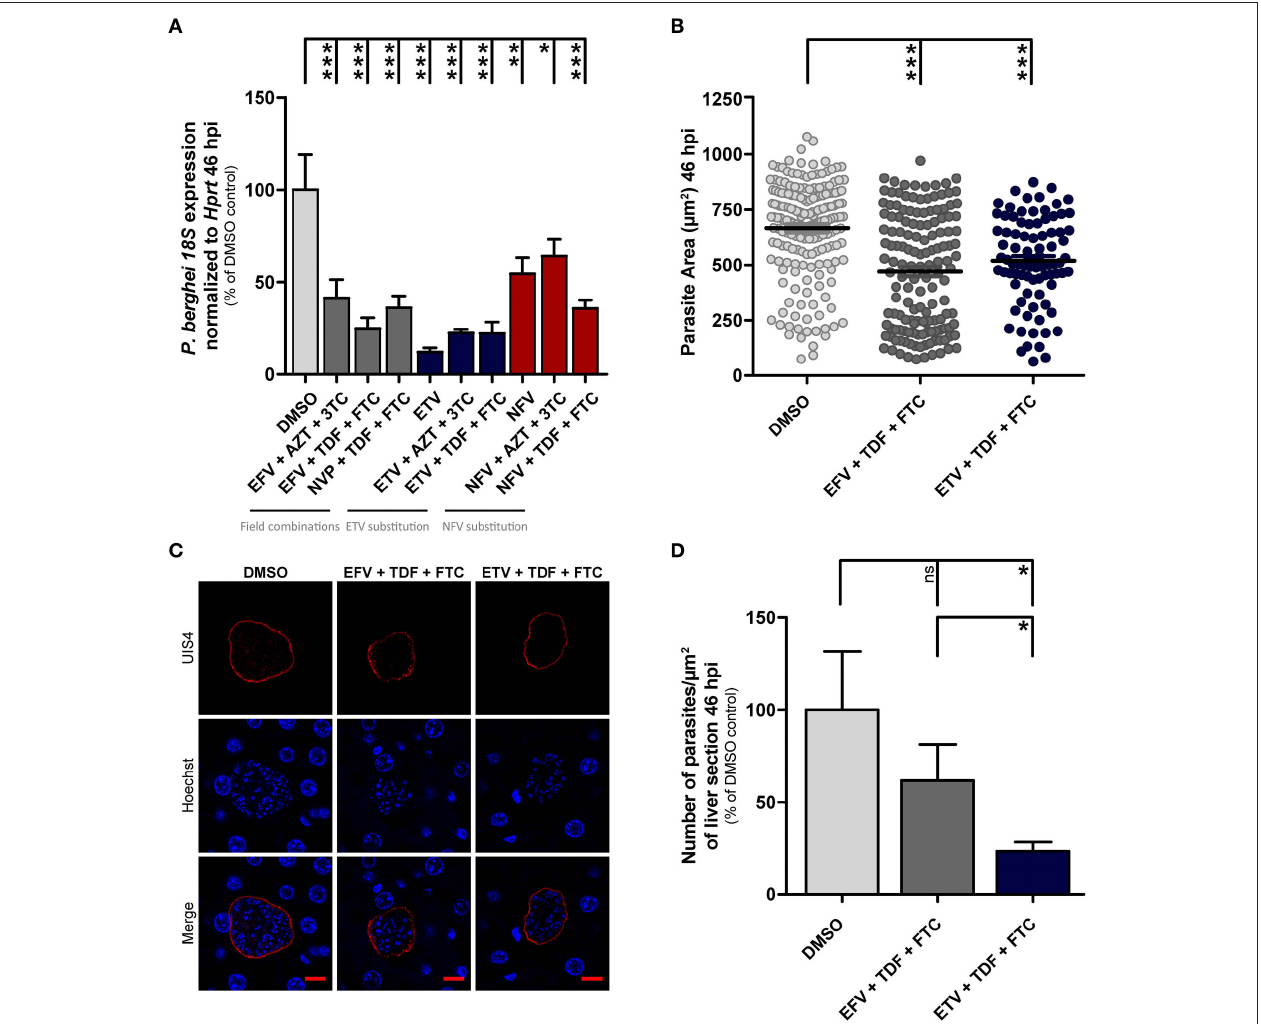
FIGURE 2 | Antiretroviral drugs decrease liver Plasmodium infection in vivo. (A) Parasite infection loads measured by qRT-PCR in the livers of mice treated with the various compounds, relative to those of DMSO-treated controls, at 46 hpi. (B) Effect of drug treatment on parasite size as a surrogate of parasite development at 46 hpi. Analysis was performed by immunofluorescence microscopy through quantification of EEF area. (C) Representative confocal microscopy images of liver parasites in treated and control mice. Red, Pb UIS4 labeling showing the PVM; blue, Hoechst nuclear staining. Scale bars, 10 µ m. (D) Parasite density per square millimeter of mouse liver sections following treatment with selected drug combinations, or with the vehicle, at 46 hpi. Plots represent the mean values of at least two independent experiments with error bars indicating SEM. One-way ANOVA with post-test Dunnett. ns, Not significant, * p < 0.05, ** p < 0.01, *** p < 0.001. Light gray bars or circles in panels (A,B,D) correspond to vehicle controls, dark gray bars or circles correspond to field combinations, blue bars or circles correspond to replacement with the NNRTI ETV, and red bars in (A) correspond to replacement with the PI